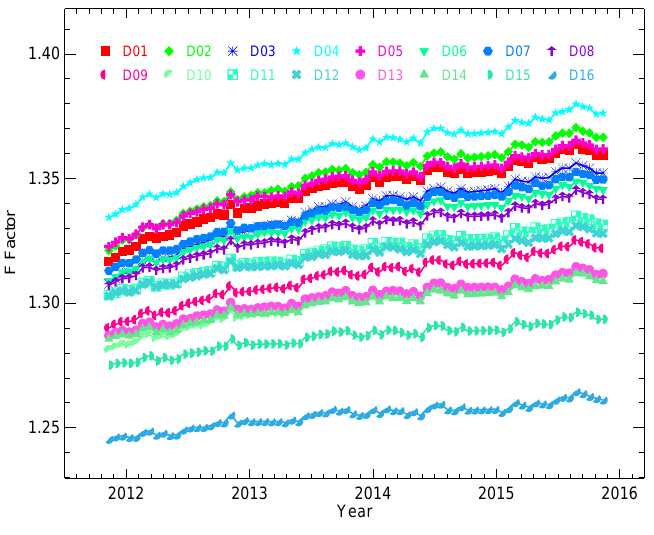
Figure 6. VIIRS band M1 HAM 1 HG SD F-factors.